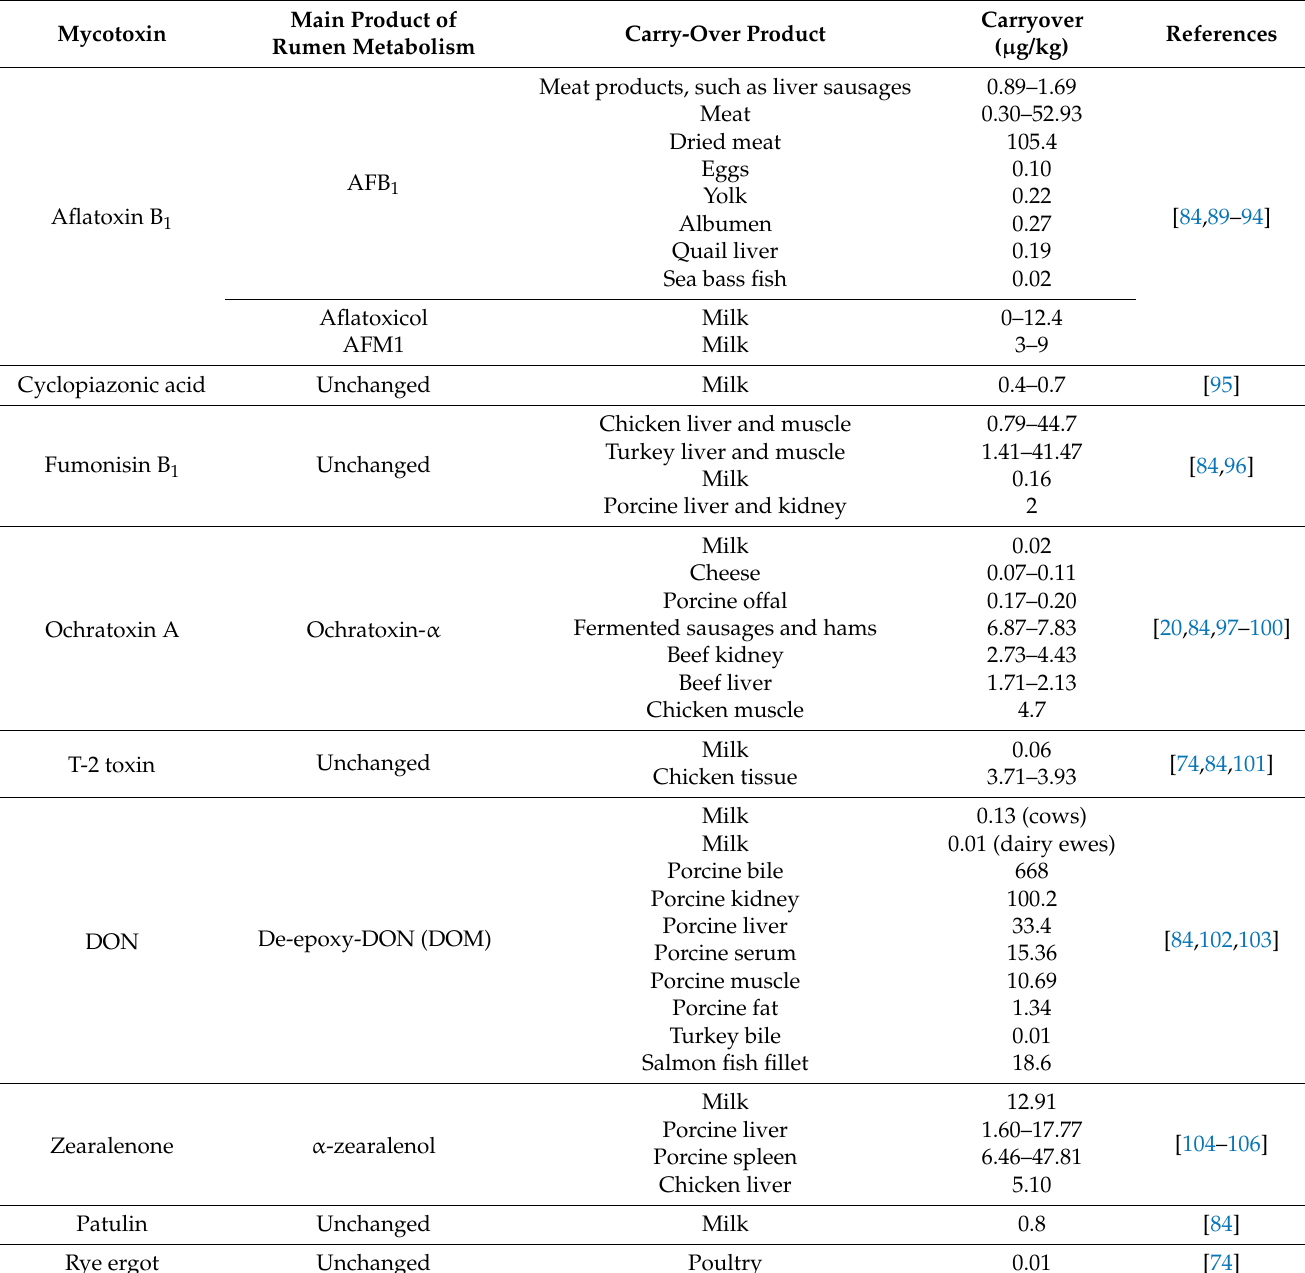
Table 4. Animal exposure to mycotoxins and rate of mycotoxin carryover in animal